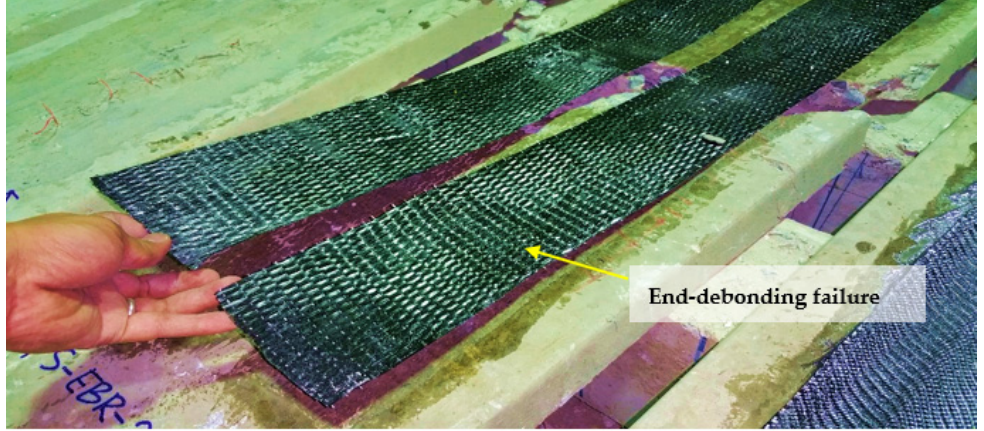
Figure 5. Intermediate crack-induced interfacial debonding failure of specimens with end-tapering.